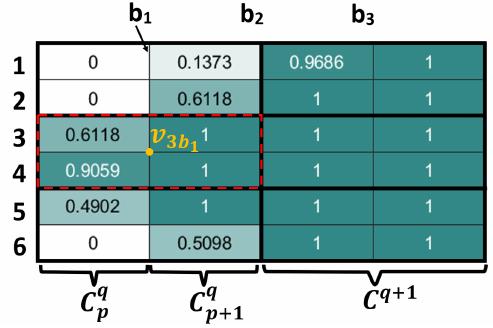
Figure 2. Mapping of the area of interest in a grid.